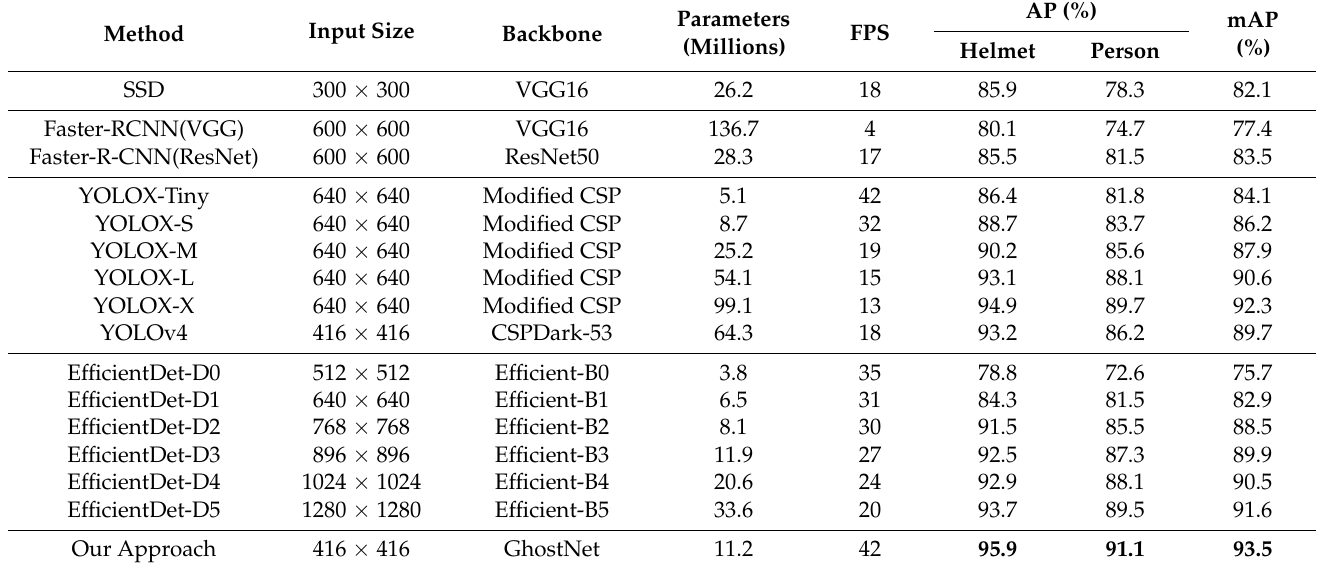
Table 4. Comparison of quantitative experimental results on the same test set, where bold numbers indicate the best value in each column. “Helmet” and “Person” columns indicate whether the individual wears a safety helmet or not, respectively.